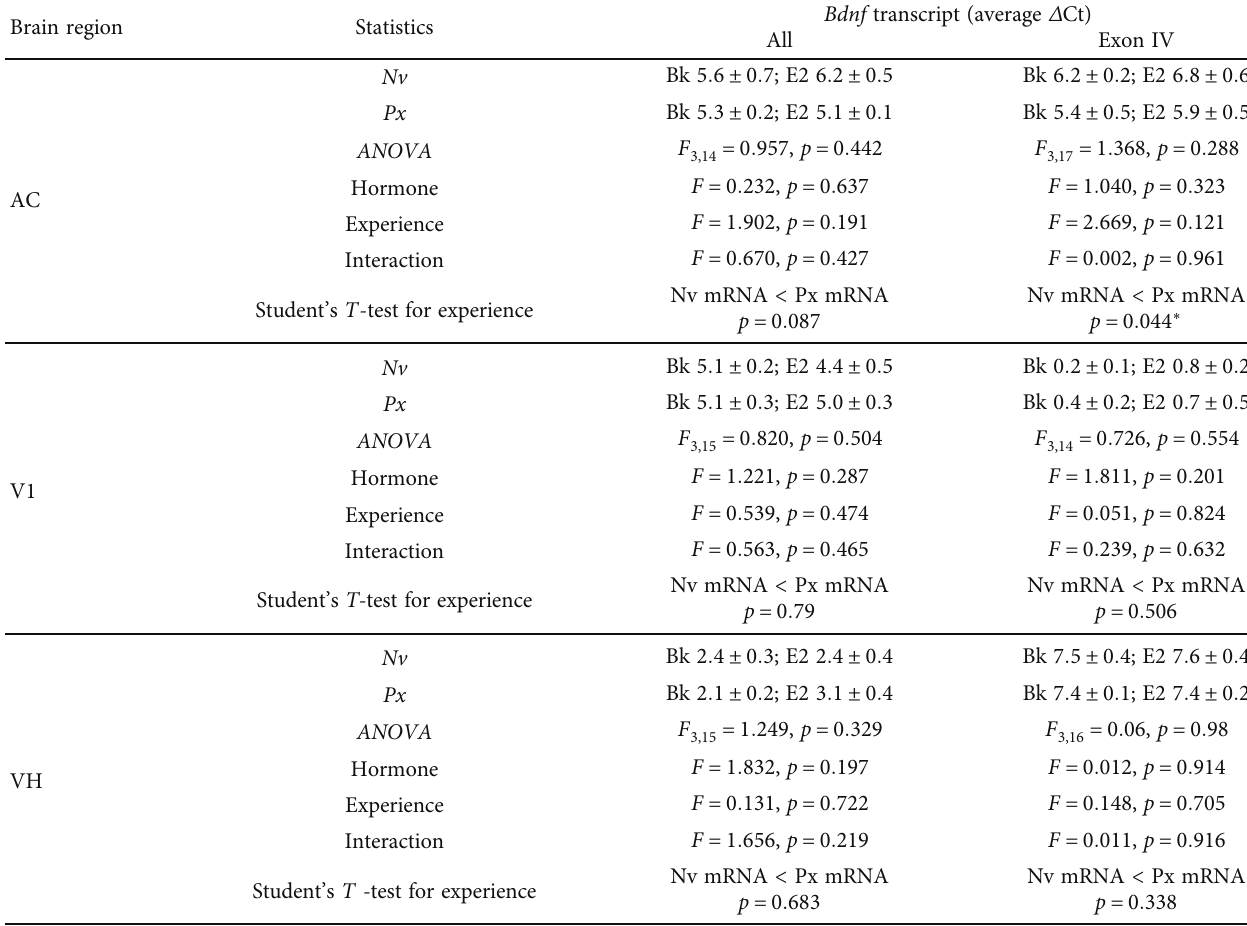
Table 2: Results for Bdnf All and exon IV transcription in AC, V1, and VH from the most conservative runs. Brain